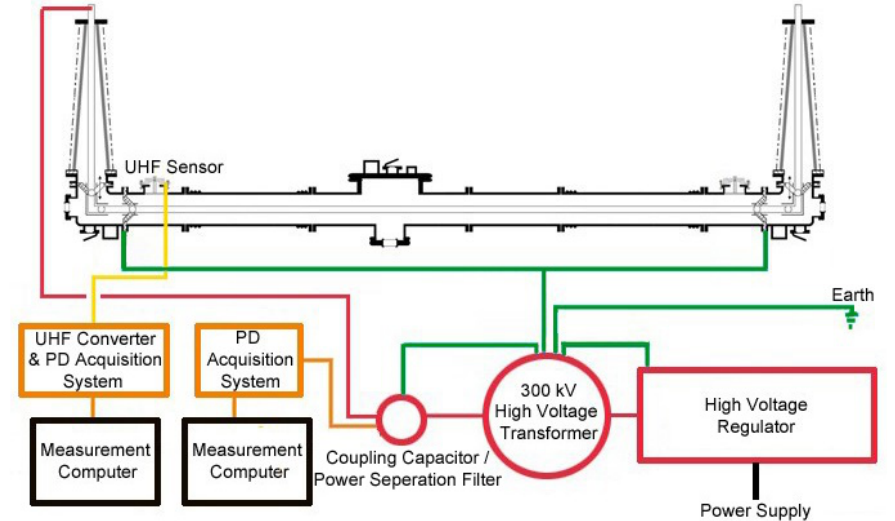
Figure 5. Practical test arrangement including gas insulated line demonstrator, partial discharge acquisition equipment, measuring computers and high voltage transformer. acquisition equipment, measuring computers and high voltage